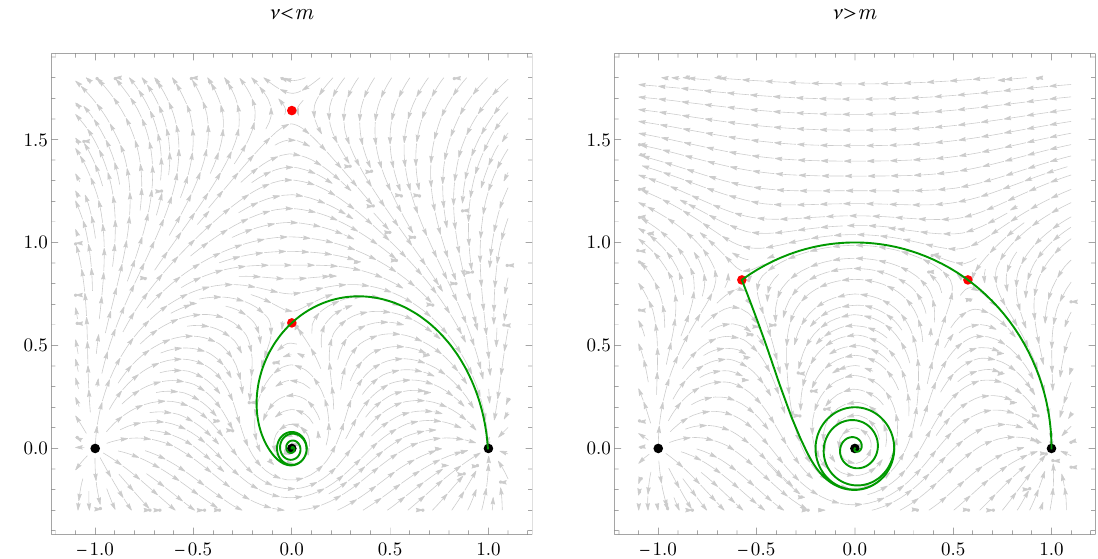
) m , for ν < m 2 1+ x − and p − are shown in red, and the branch • , + • , − (the lower saddle • , −